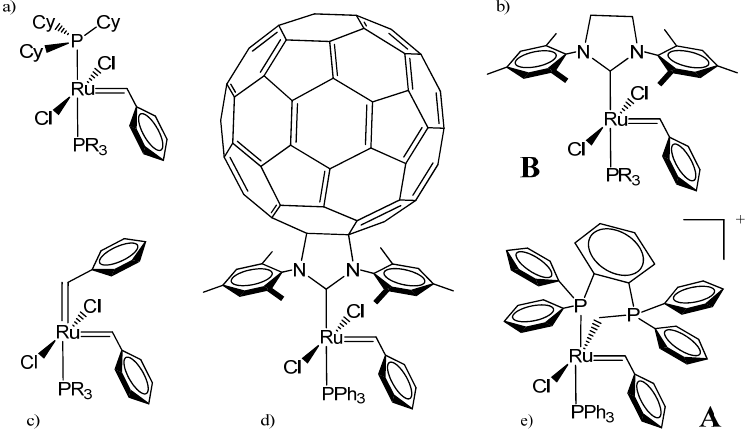
Figure 1. Classification of ruthenium precatalysts for olefin metathesis: ( a ) first generation; ( b ) second generation, and examples of futurist generations: ( c ) bis-benzylidene complex; ( d ) C 60 - N -heterocyclic carbene (NHC)-based complex; and ( e ) phosphine–phosphonium ylide complex (R = Ph or